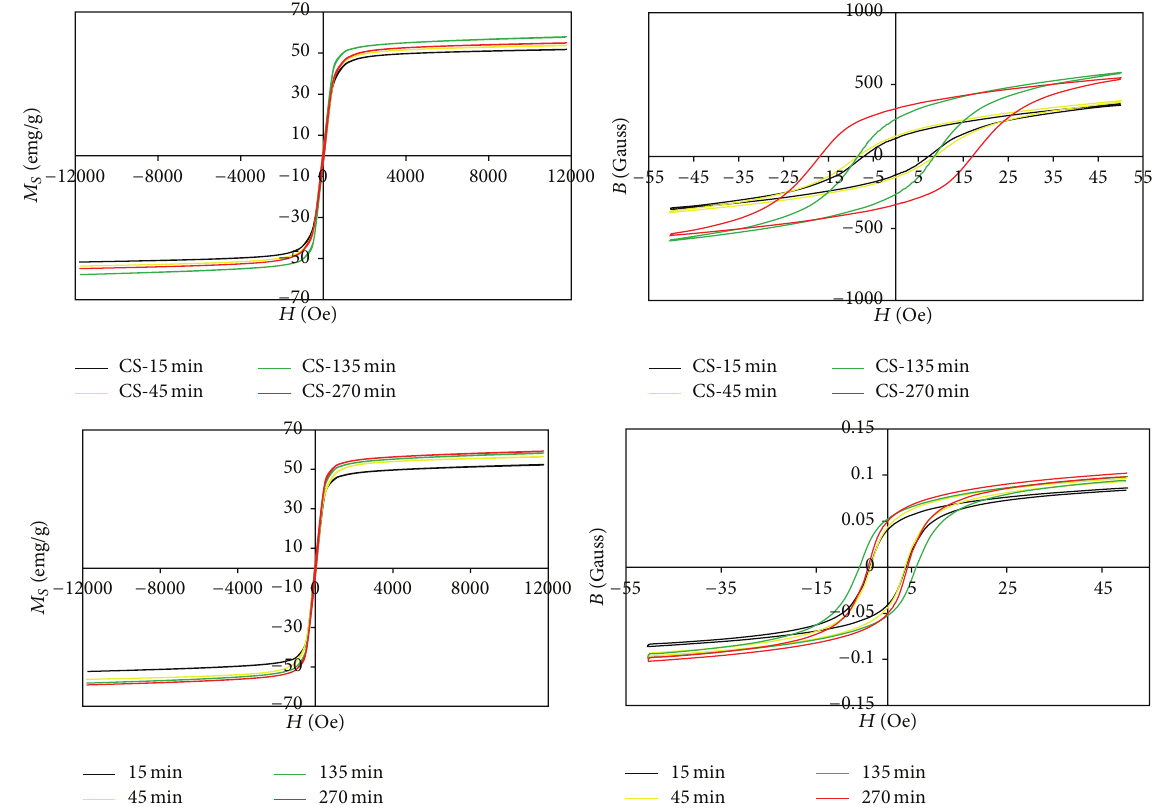
Figure 3: Room temperature hysteresis loops ( 𝐵 - 𝐻 and 𝑀 - 𝐻 ) for the two types of samples at different sintering times.